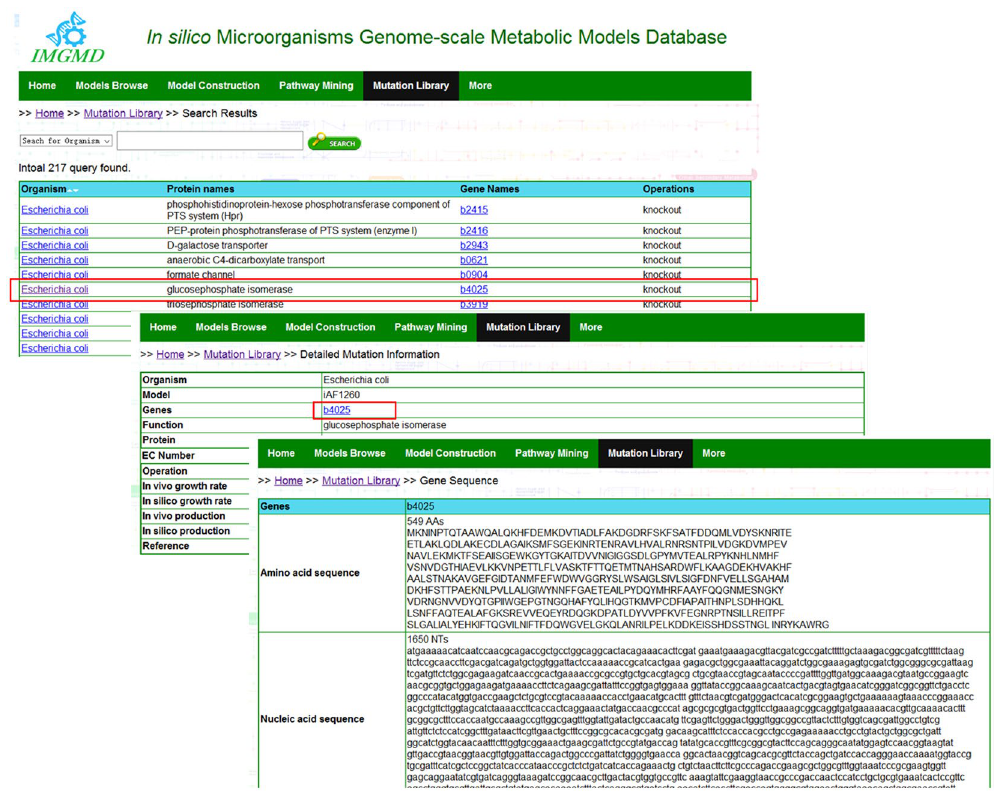
Figure 5. In silico and in vivo results on the b4025 deletion in the i AF1260 model, and detailed information on b4025 in E . coli .